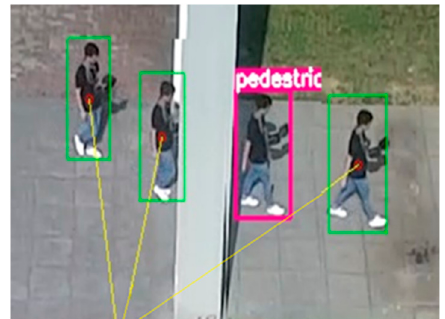
Figure 11. The experiment of automatic initialization and intelligent re-recognition.